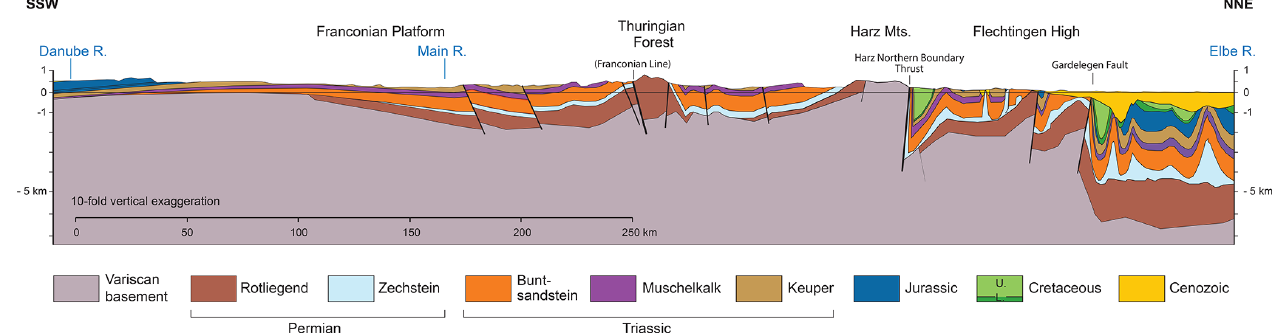
Figure 4. Regional cross section from the Danube to the Elbe (location in Fig. 3). Strong inversion-related deformation from the Thuringian Forest towards the north contrasts with long-wavelength undulations of the area to the south. Faults are shown schematically but with correct general dip. The area north of the Harz Mountains is simplified from Jähne (in Kley et al., 2008, p. 105) and Malz et al.